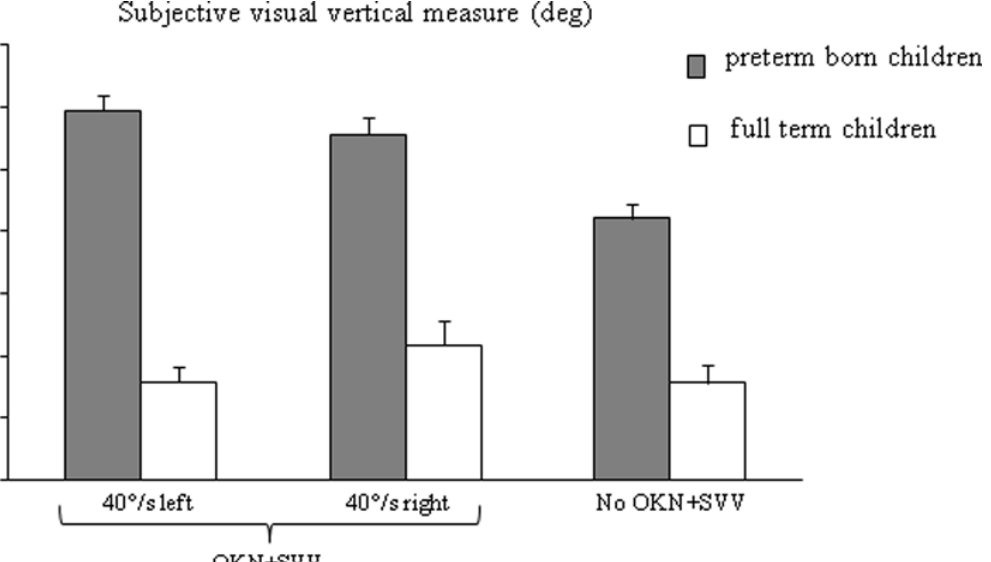
Fig 2. Mean Subjective visual vertical measure. Mean values of the SVV for the three different conditions (OKN+SVV at 40°/s toward the left and the right and the condition No OKN+SVV) for the two groups of children tested. Verticals bars indicate the standard error.